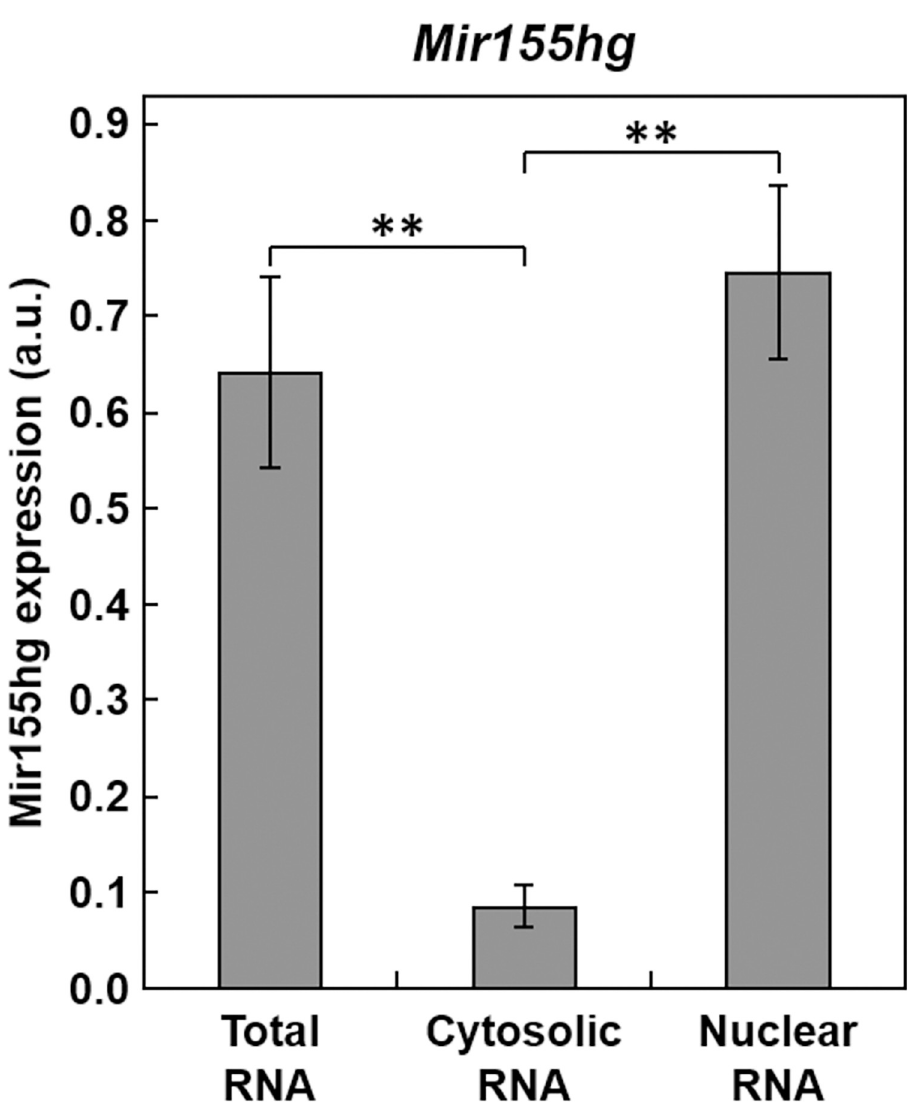
Fig 6. The localization of Mir155hg is predominantly nuclear. Total, cytosolic and nuclear RNA was extracted from ATDC5 cells and Mir155hg expression was then measured by real-time PCR and normalized to Rpl13a expression. The graph shows the mean +/- SEM of five independent experiments (one-way ANOVA followed by Tukey’s HSD, �� : p < 0.01).